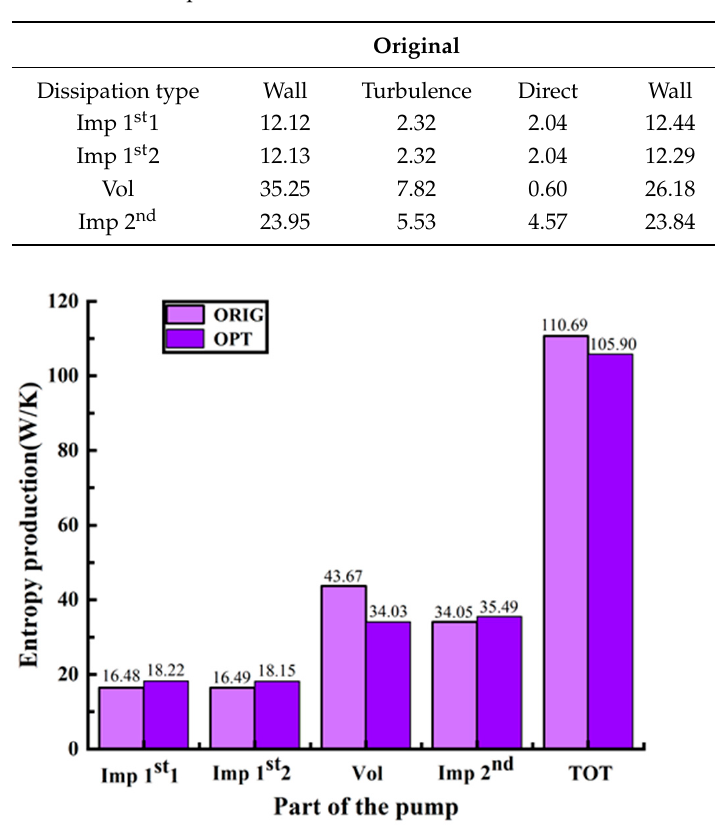
Figure 13. Comparison of entropy field values of components before and after optimization.